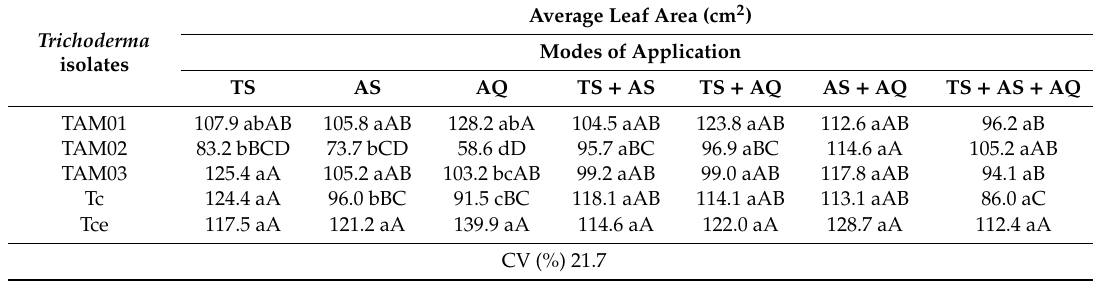
Table 6. Average leaf area of Euterpe oleracea plants submitted to di ff erent modes of application of five Trichoderma spp isolates at 132 days after